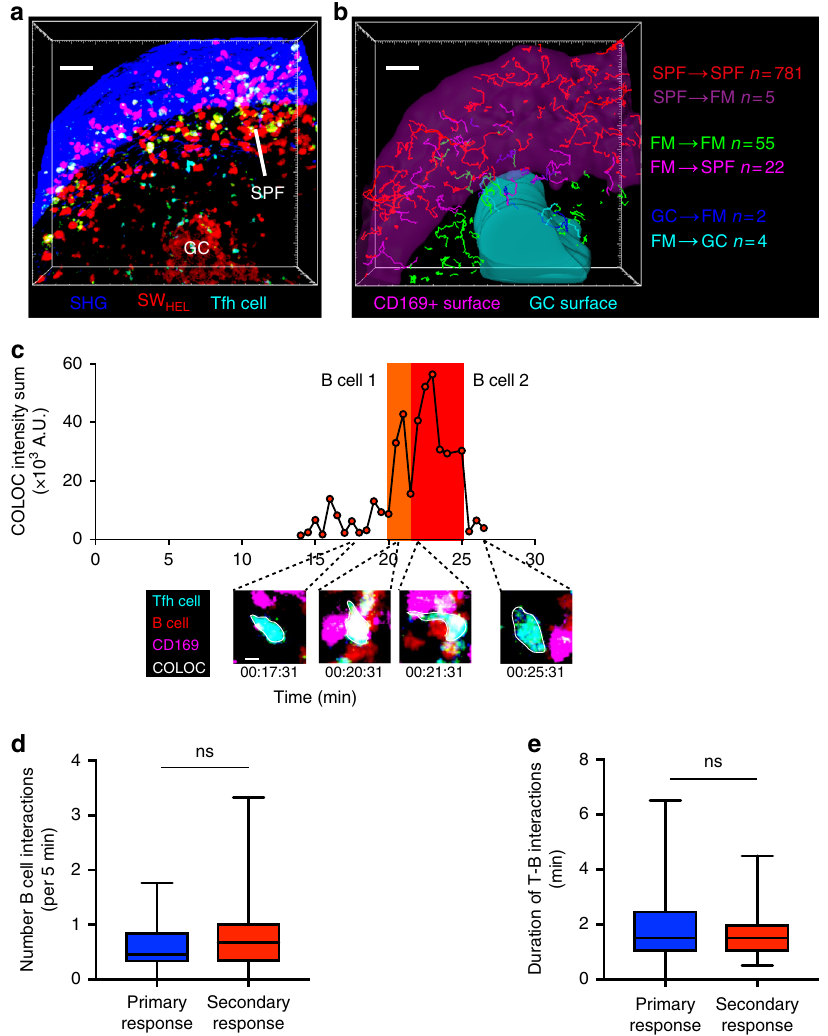
Fig. 3 MBCs cluster and interact with Tfh cells in subcapsular foci. a Maximum intensity projection (504 × 465 × 31 μ m) of follicle imaged 5 days after HEL- OVA secondary immunisation. SW HEL B cells (red), OT2 T cells (cyan), SHG (blue). Scale bar = 50 μ m. b Cell tracking of SW HEL B cell from a with tracks colour coded based on migration pattern. CD169 + subcapsular region surface (pink) and GC surface (cyan). Representative 100 tracks out of a total of 781 in the subcapsular region are shown. See also Supplementary Movie 4. Scale bar = 50 μ m. c Time-lapse images 5 days after secondary immunisation, showing colocalisation (white) of Tfh cells (cyan) with SW HEL B cells (red). CD169 + SCS macrophages (pink), SHG (blue). Scale bar = 5 μ m. See also Supplementary Movie 5. d Number of times a T cell interacts with a B cell per 5 min, 5 days after primary immunisation (blue) or secondary immunisation (red). Data are combined from 2 movies in the primary response, n = 30, and 4 movies in the secondary response, n = 33. Comparison between groups utilised one-tailed unpaired Student ’ s t -test. e Duration of T-B interactions 5 days after primary immunisation (blue) or secondary immunisation (red). Data is combined from 2 movies in the primary response, n = 49, and 4 movies in the secondary response, n = 49. Comparison between groups utilised one- tailed unpaired Student ’ s t -test. Box plots show centre line as median, box limits as upper and lower quartiles, whiskers as minimum to maximum